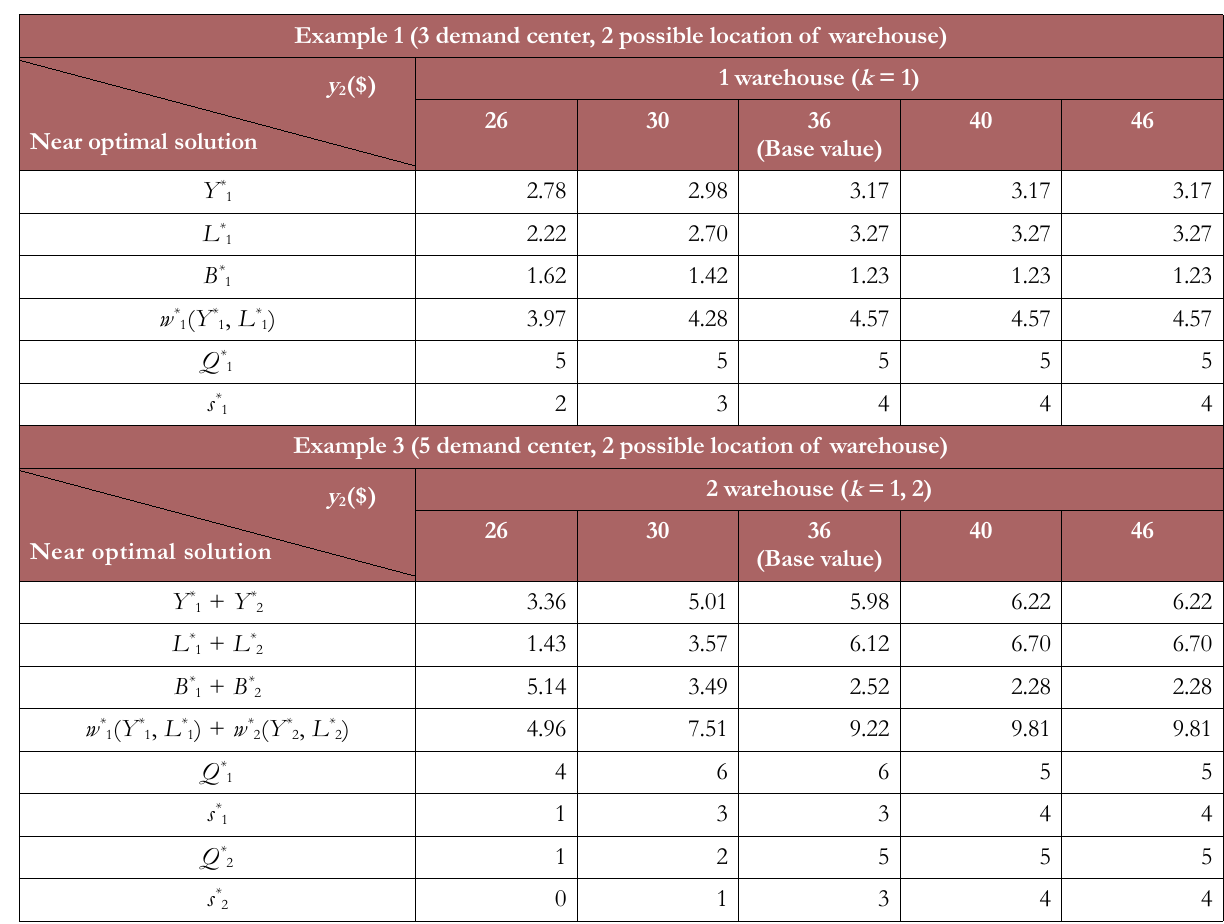
Table 8. Impact of the unit lost sales